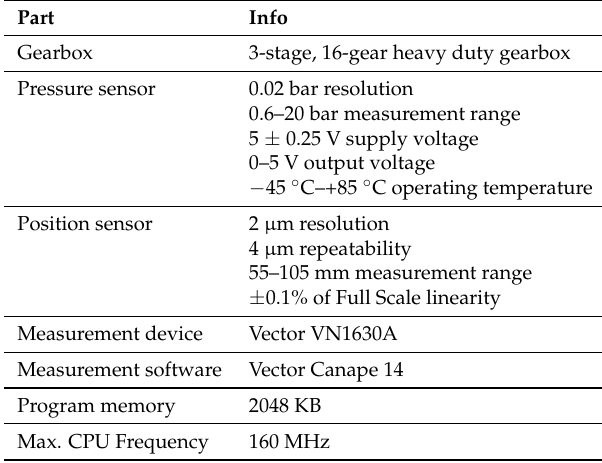
Table 4. Measurement configuration.